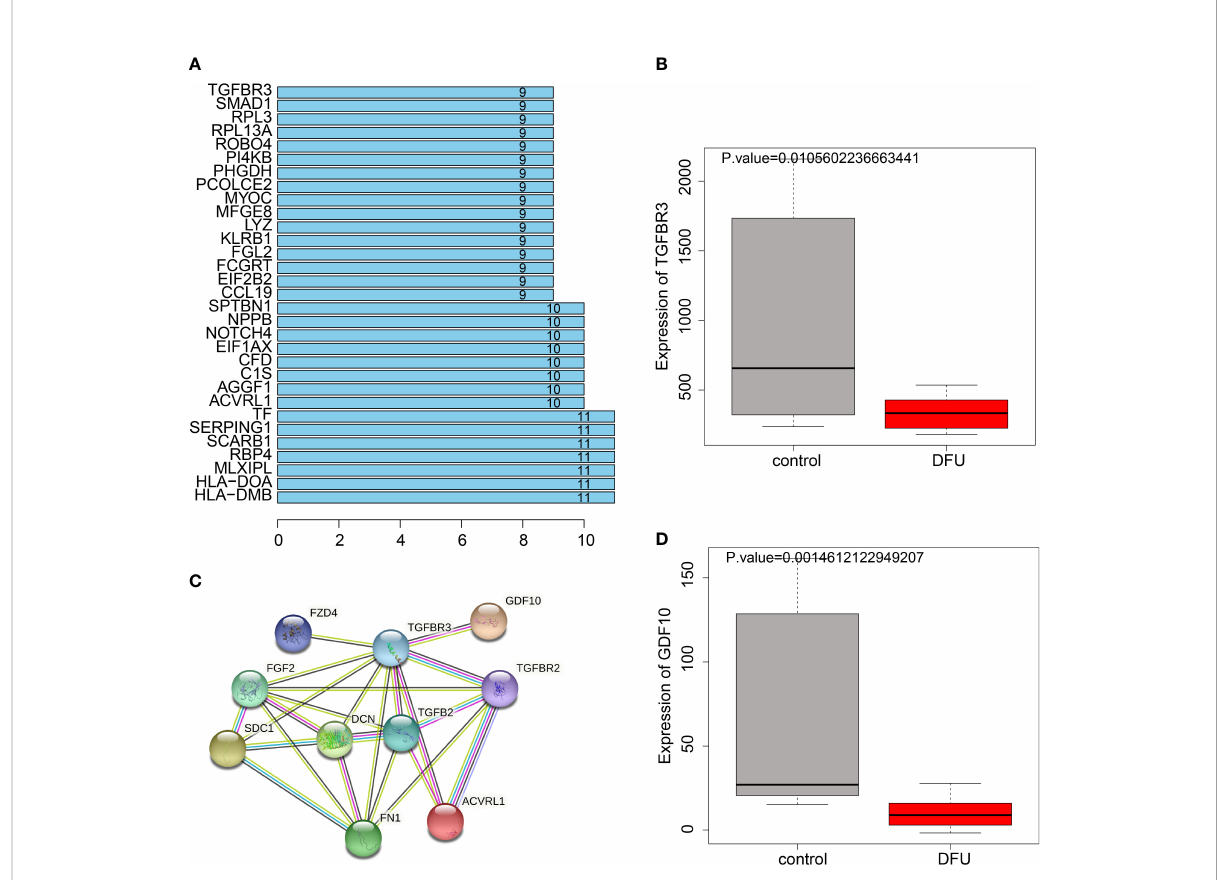
FIGURE 5 PPI relationship between TGFBR3 and GDF10. (A) , Degree values of the genes. (B) , PPI diagram showing interaction of genes with TGFBR3. (C) , Expression of TGFBR3 in DFU in GSE134431 dataset. (D) , GDF10 expression in DFU in GSE134431